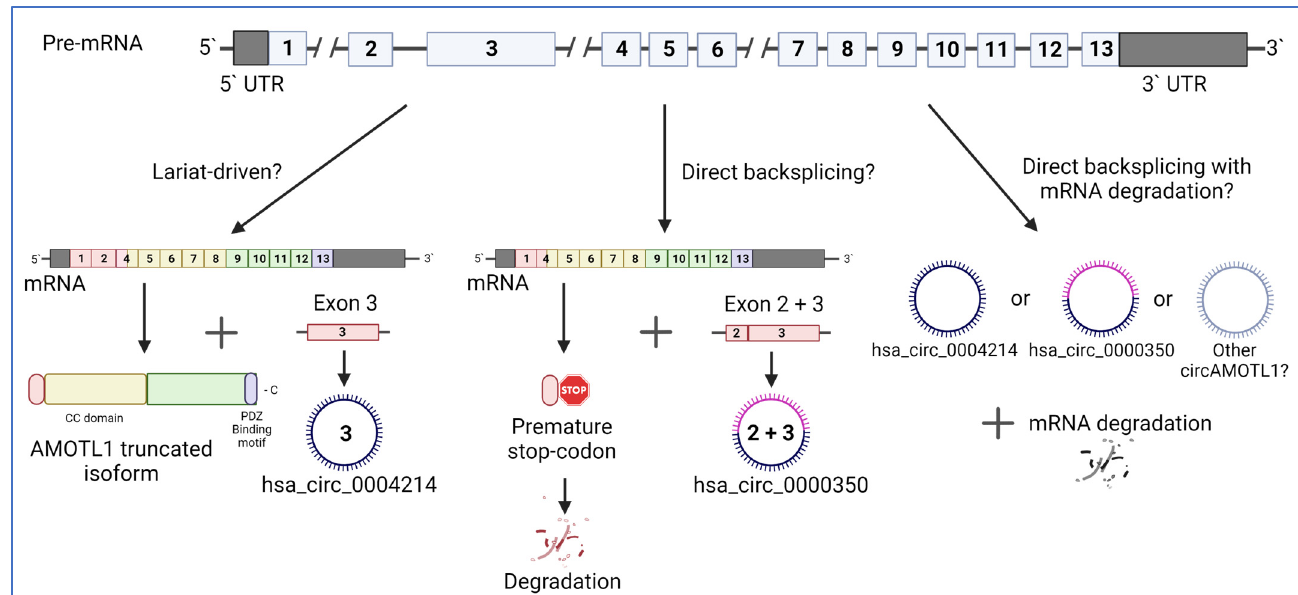
Figure 3. Hypothetical models of AMOTL1 circRNAs production. A lariat-driven mechanism could produce circAmotl1 containing only exon 3 (hsa_circ_0004214) during RNA splicing, leading to the production of the truncated protein. On the other hand, the direct backsplicing could lead to the production of circAMOTL1 with exons 2 and 3 (hsa_circ_0000350). The other product from this process is mRNA with a premature stop codon, which does not allow for AMOTL1 protein synthesis. The alternative hypothesis would include direct backsplicing with the degradation of the remaining mRNA.